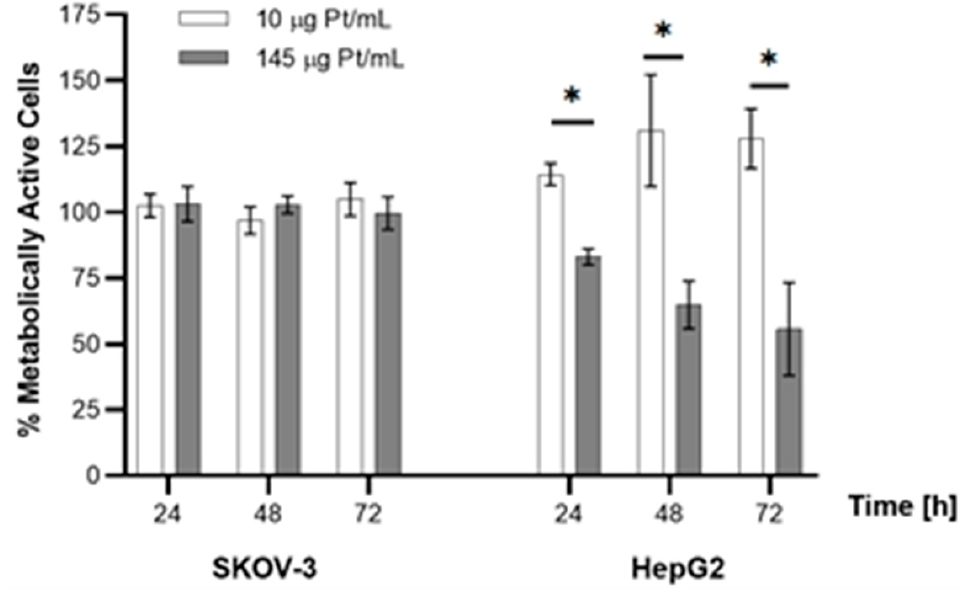
Au@Pt conjugates.